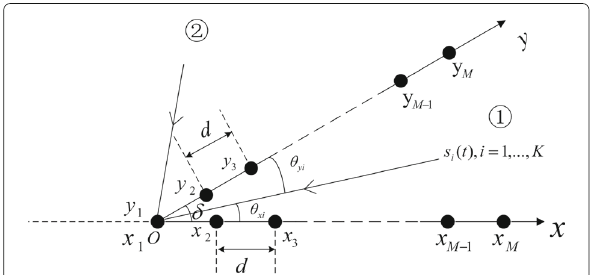
Fig. 1 Arbitrary cross-linear array for 1D DOA estimation